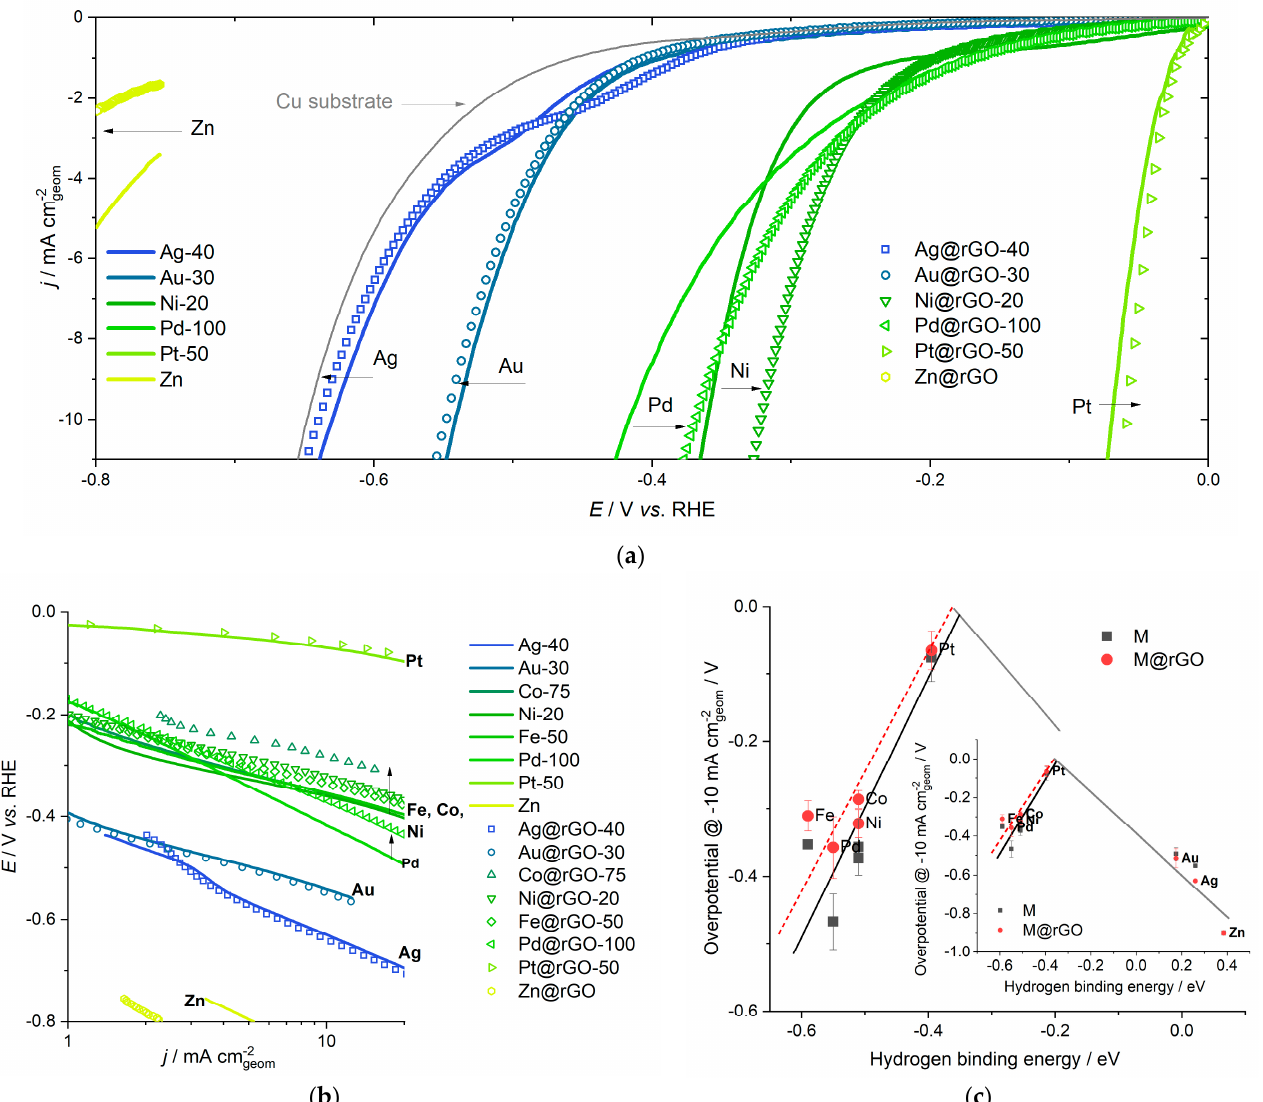
Figure 5. ( a ) HER polarization curves for selected metals with (M@rGO- t ) and without rGO support (M- t ), t is the deposition time in seconds (for Zn and Zn@rGO catalyst only parts of the polarization curves at deeper negative potentials are shown to prevent Zn dissolution); ( b ) Tafel plots for entire series of catalysts (the same notation as for ( a )); ( c ) volcano plot constructed using η 10 values and calculated hydrogen binding energies, focusing on the strong binding branch, while inset gives the complete HER volcano curve. Error bars give the range of η 10 values for different deposition times.